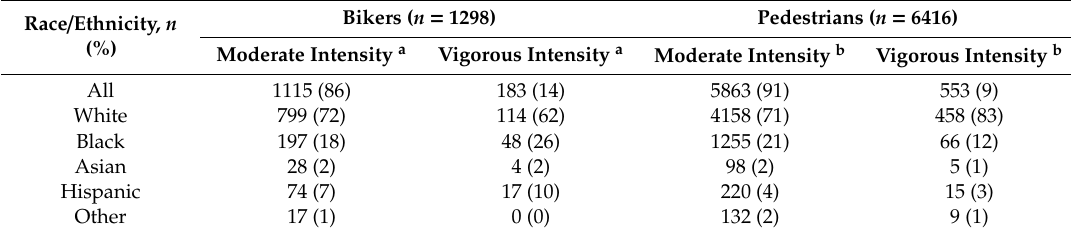
Table 3. Physical activity level by